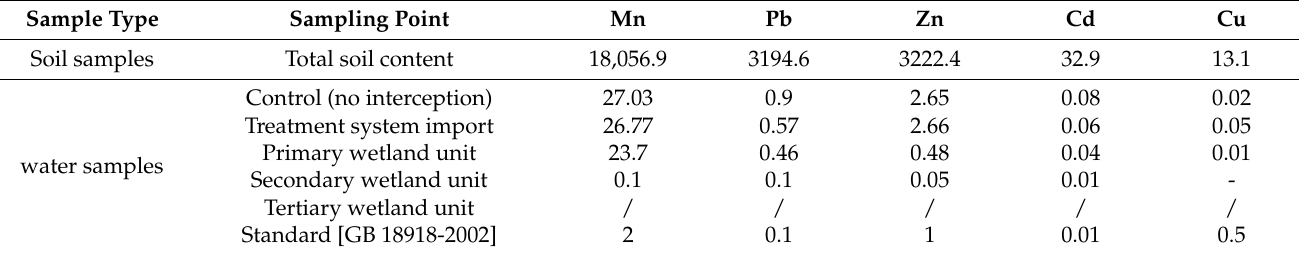
Table 4. Heavy metal content in water samples collected in the outlet of treatment cells (mg/kg − 1 ). Sample